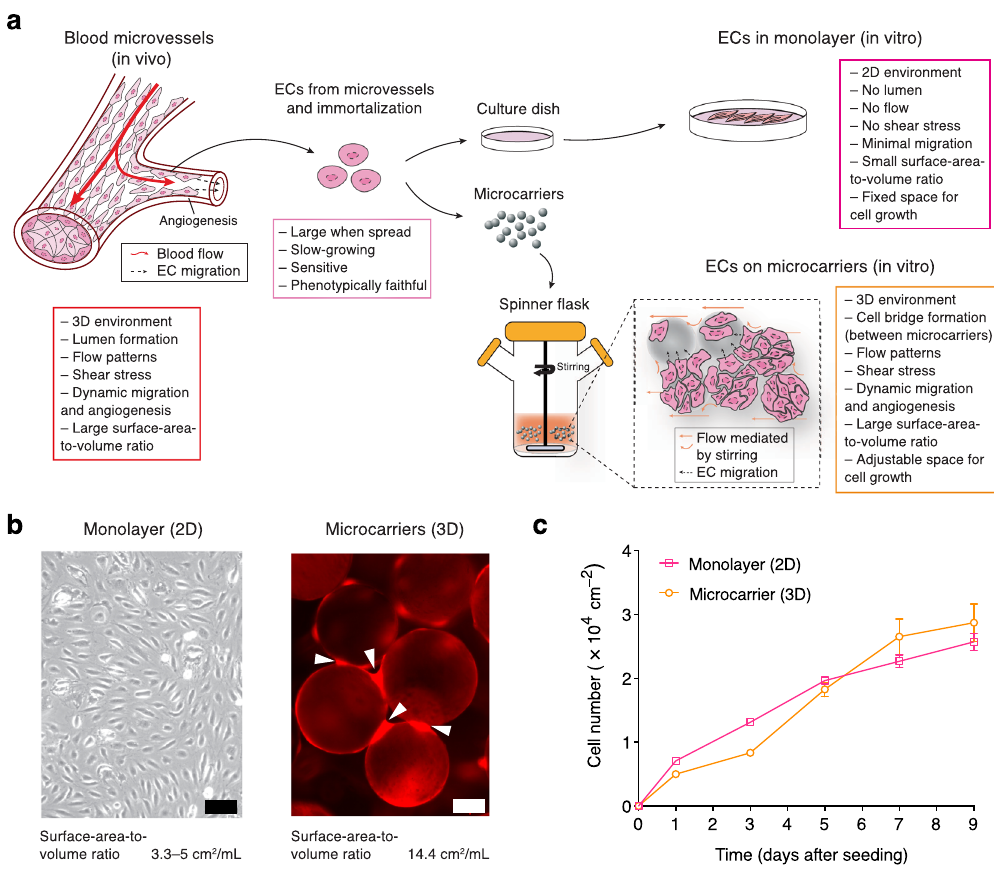
Fig. 1 In vitro culture of immortalized human microvascular blood ECs. a Schematics of strategies for in vitro culture of human microvascular blood ECs. ECs are isolated from blood vessels and immortalized for in vitro culture where they are cultivated in monolayer using fl at-surface culture vessels or on microcarriers stirred in spinner fl asks. b Representative images of ECs cultivated using monolayer culture (parental ECs) or microcarrier-based culture (parental ECs expressing a red fl uorescent protein DsRed-Max). White arrowheads indicate cell bridges that suggest bead-to-bead transfer. Scale bar (black), 100 µ m. Scale bar (white), 50 µ m. c Cell number assessed from monolayer culture and microcarrier-based culture of ECs. Error bars represent ± SEM ( n = 3 independent